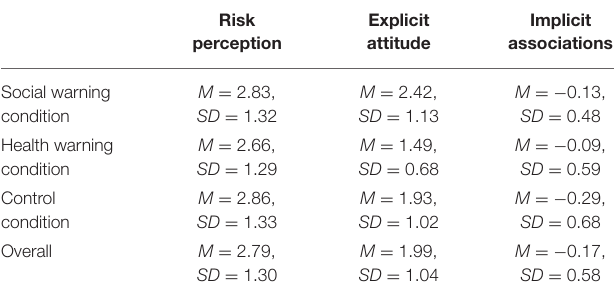
TABLE 4 | Means, standard deviation for all dependent variables of Study